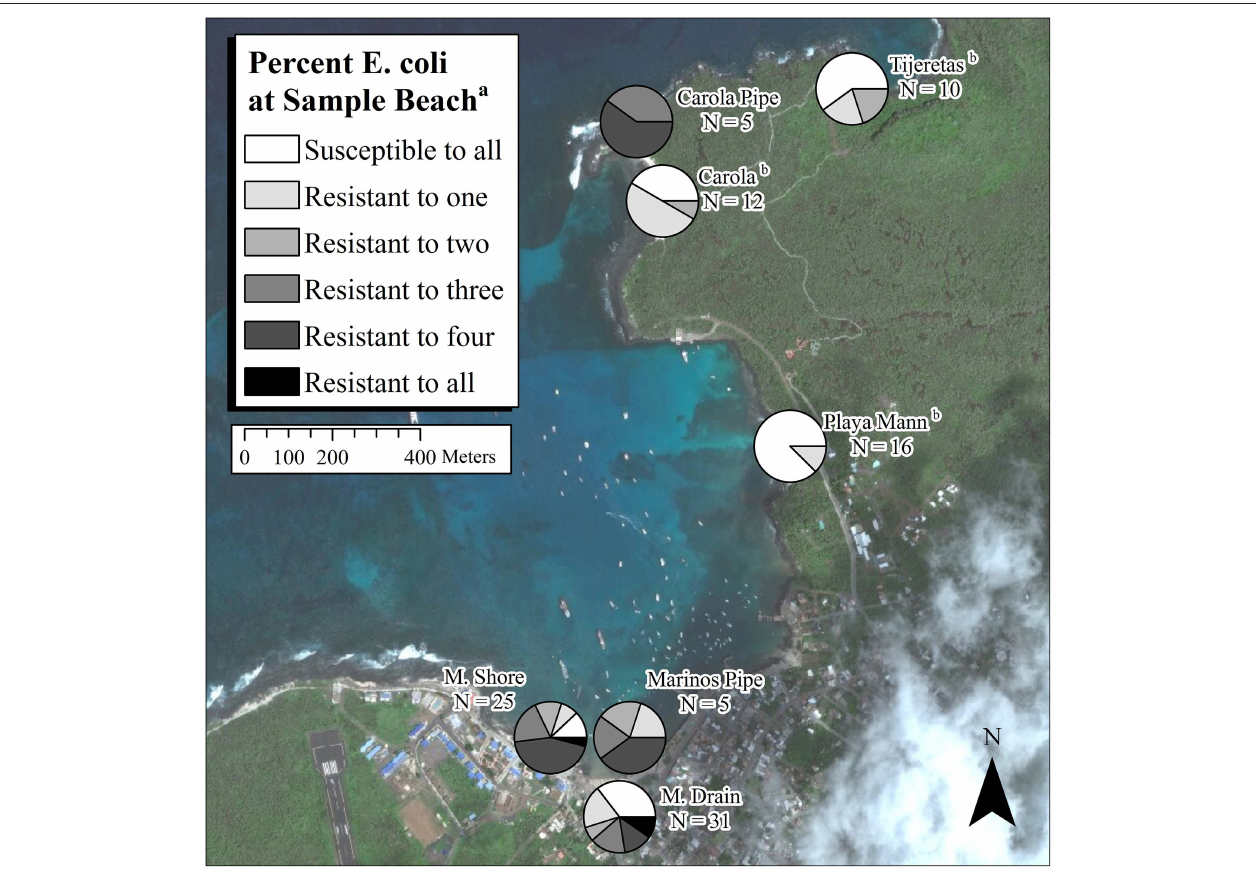
FIGURE 3 | Amount of antibiotic resistance at each sample beach. a Five antibiotics were tested, including penicillin, ciprofloxacin, gentamicin, tetracycline, and trimethoprim/sulfamethoxazole. b Threesiteswereincludedwithoutsewageeffluentorrunofffromadevelopedarea. N = numberof E.coli